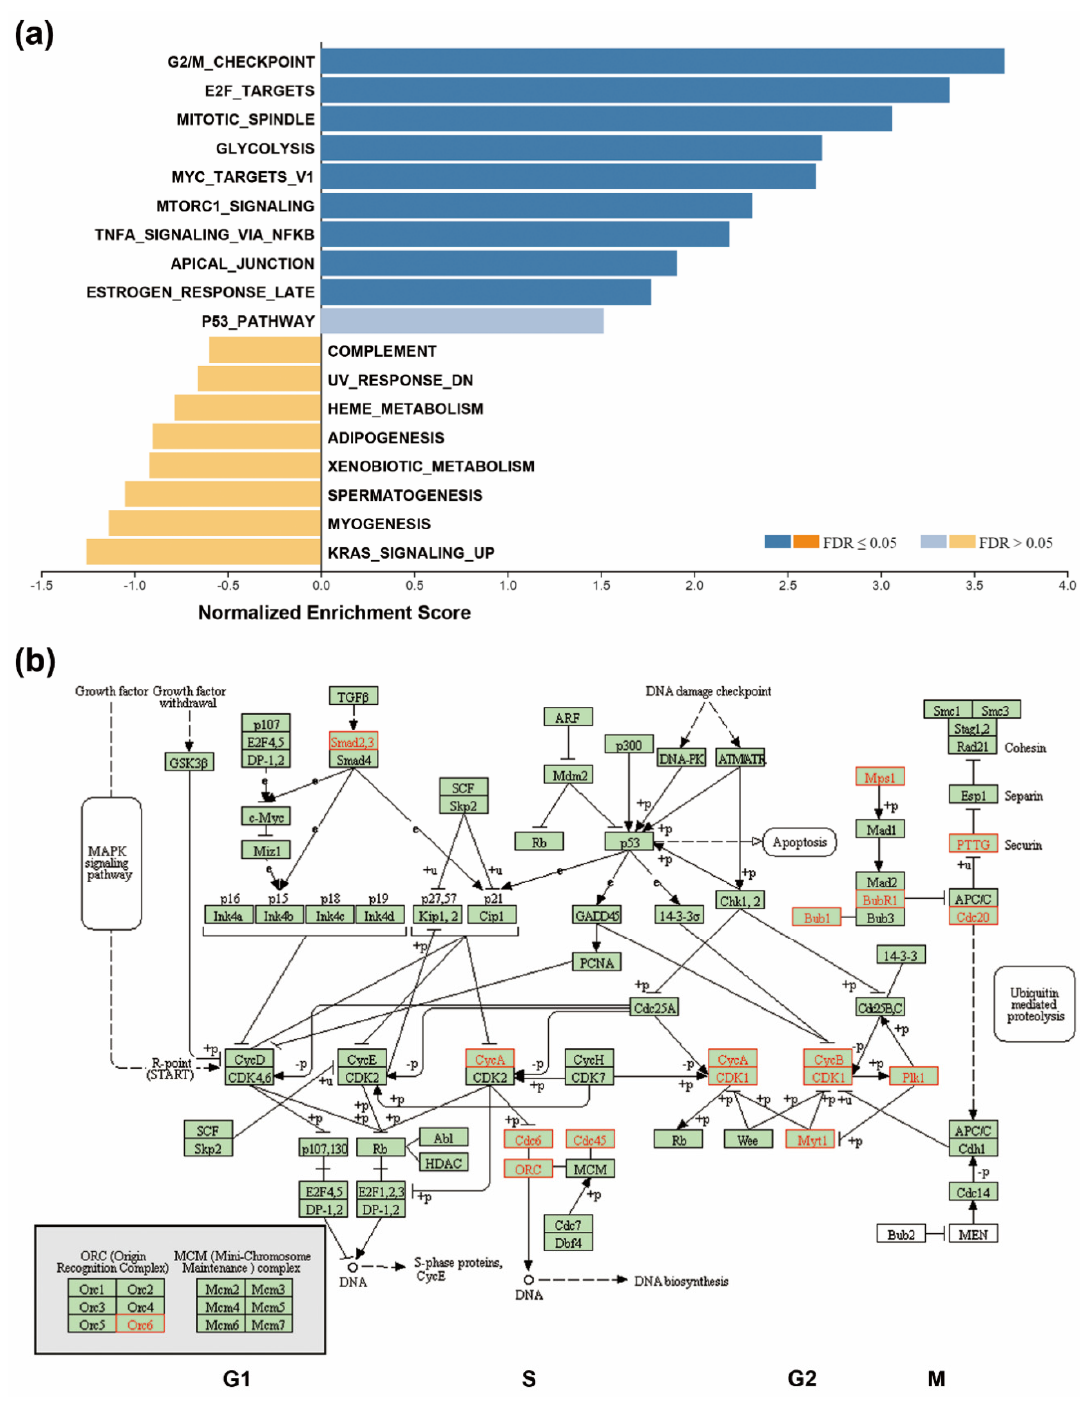
Figure 2. Upregulation of cell cycle-related genes in SMAD4-deleted PDAC. ( a ) Gene set enrichment analysis (GSEA) for the over- and under-expressed genes in SMAD4-deleted PDAC patients was performed using the WebGestalt online tool; ( b ) Kyoto Encyclopedia of Genes and Genomes (KEGG) cell cycle pathway mapping was performed using the WebGestalt online tool. The o ffi cial gene symbols for the mapped genes were annotated and highlighted in red (over-expressed) and blue (under-expressed). No under-expressed genes were enriched in this